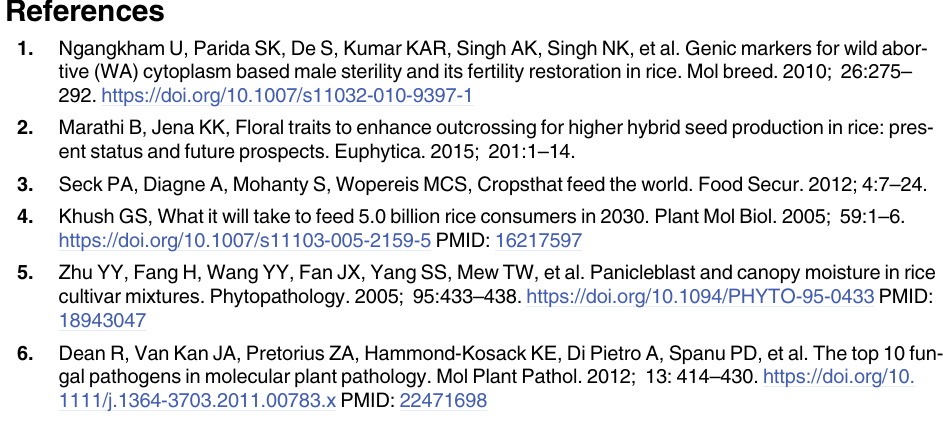
S1 Table. Details of landraces used in the current study. S2 Table. Genotyping of 161 landraces using markers associated with blast resistance genes, associated gene frequency and their phenotypic reaction to leaf blast in uniform blast nursery. S3 Table. Population structure group of 161 landraces based on inferred ancestry